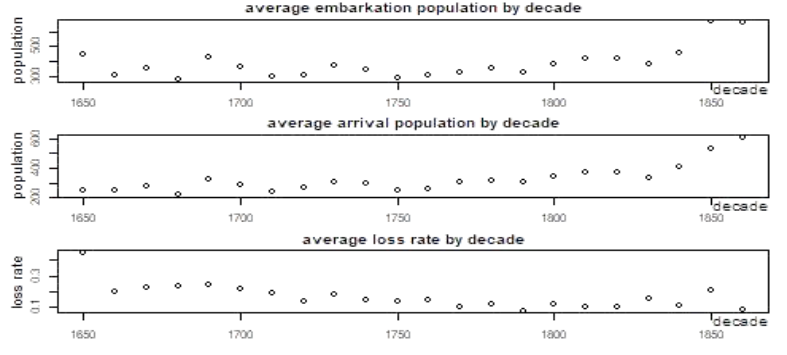
Figure 7. Captives: Total documented embarkations, arrivals, and percentage loss: average by decade. (Data3 “Documented routes & captives,” 4899